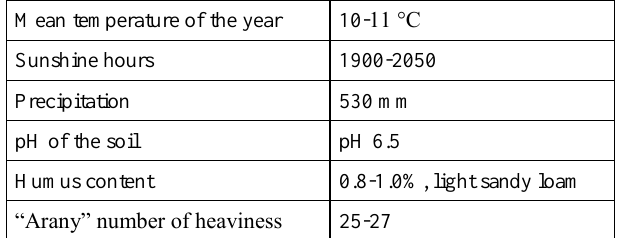
Table 1 . Ecological parameters of the experimental